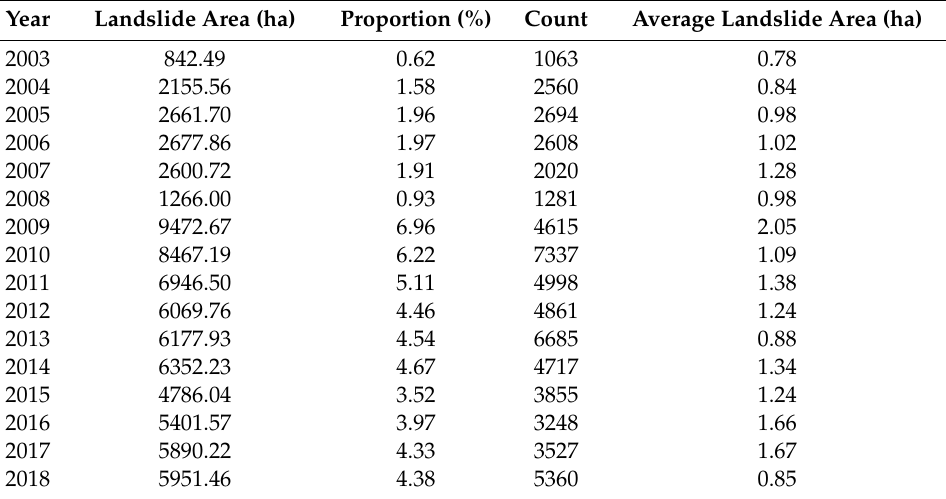
Table 2. Statistics of landslide sites over the years in the study area.